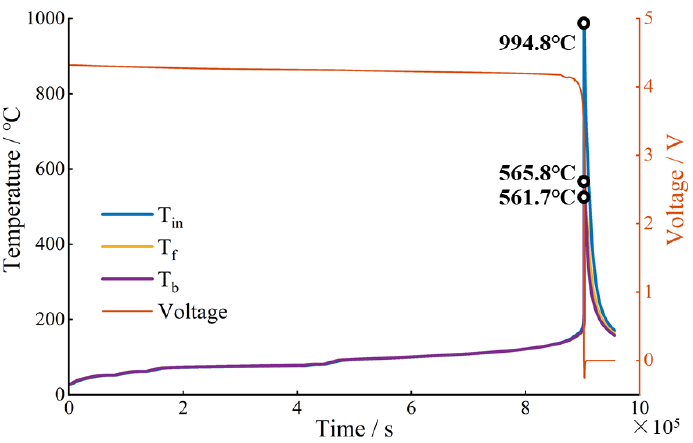
Figure 6. TR characterization of cell under EV-ARC test.